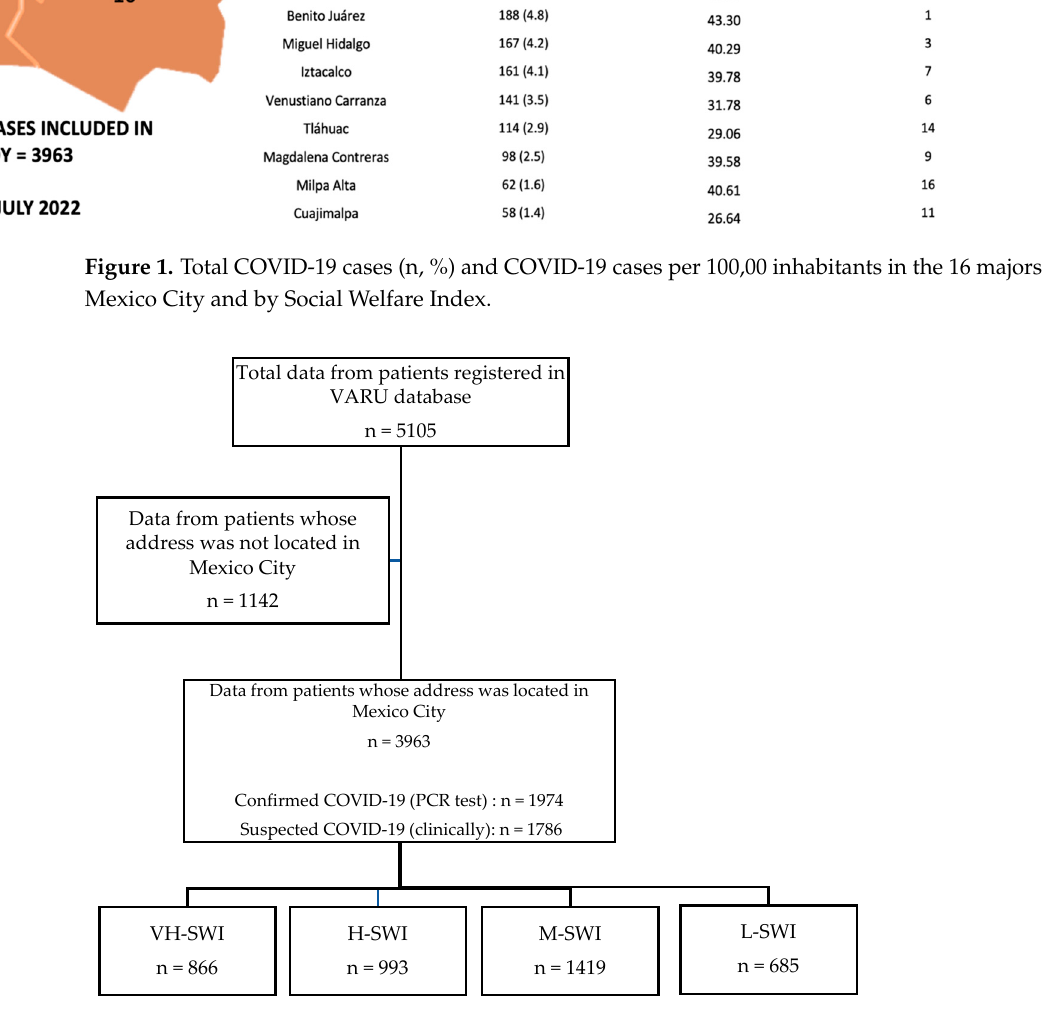
Figure 2. Flow chart of the data entering in the analysis.